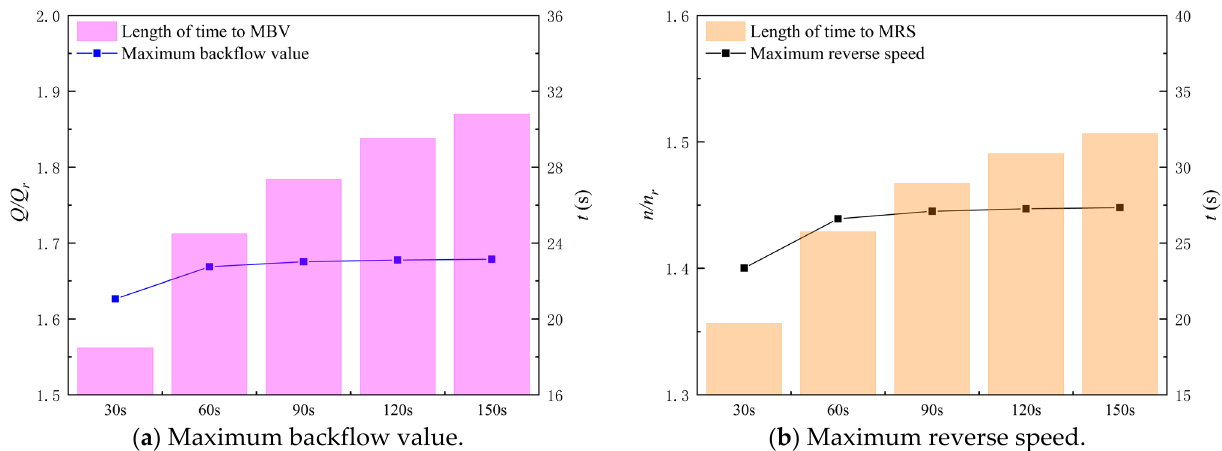
Figure 15. MBV of the LAPS and MRS of the pump at different gate closing speeds.